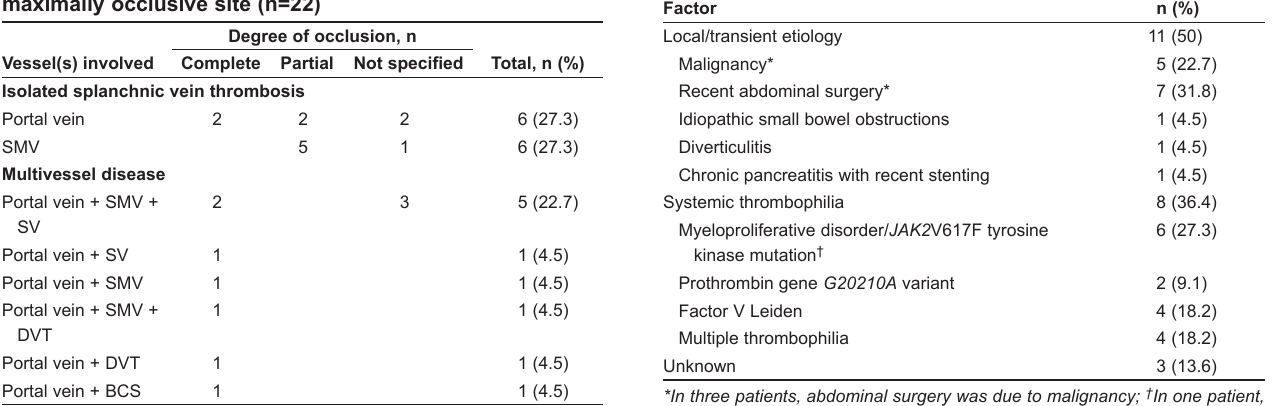
TABle 1 Splanchnic vein involvement and degree of occlusion at maximally occlusive site